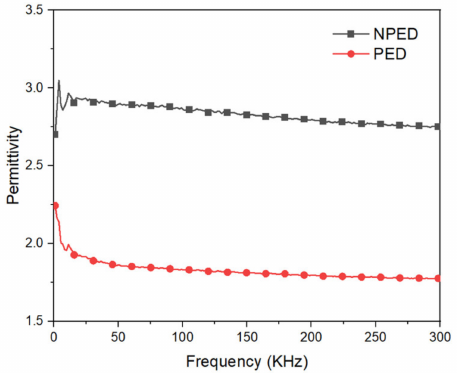
Figure 11. Frequency dispersion of